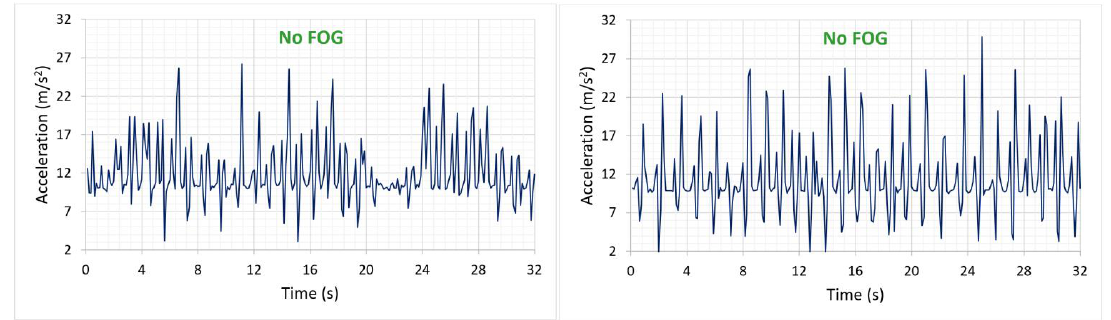
Figure 7. Signals of patients without